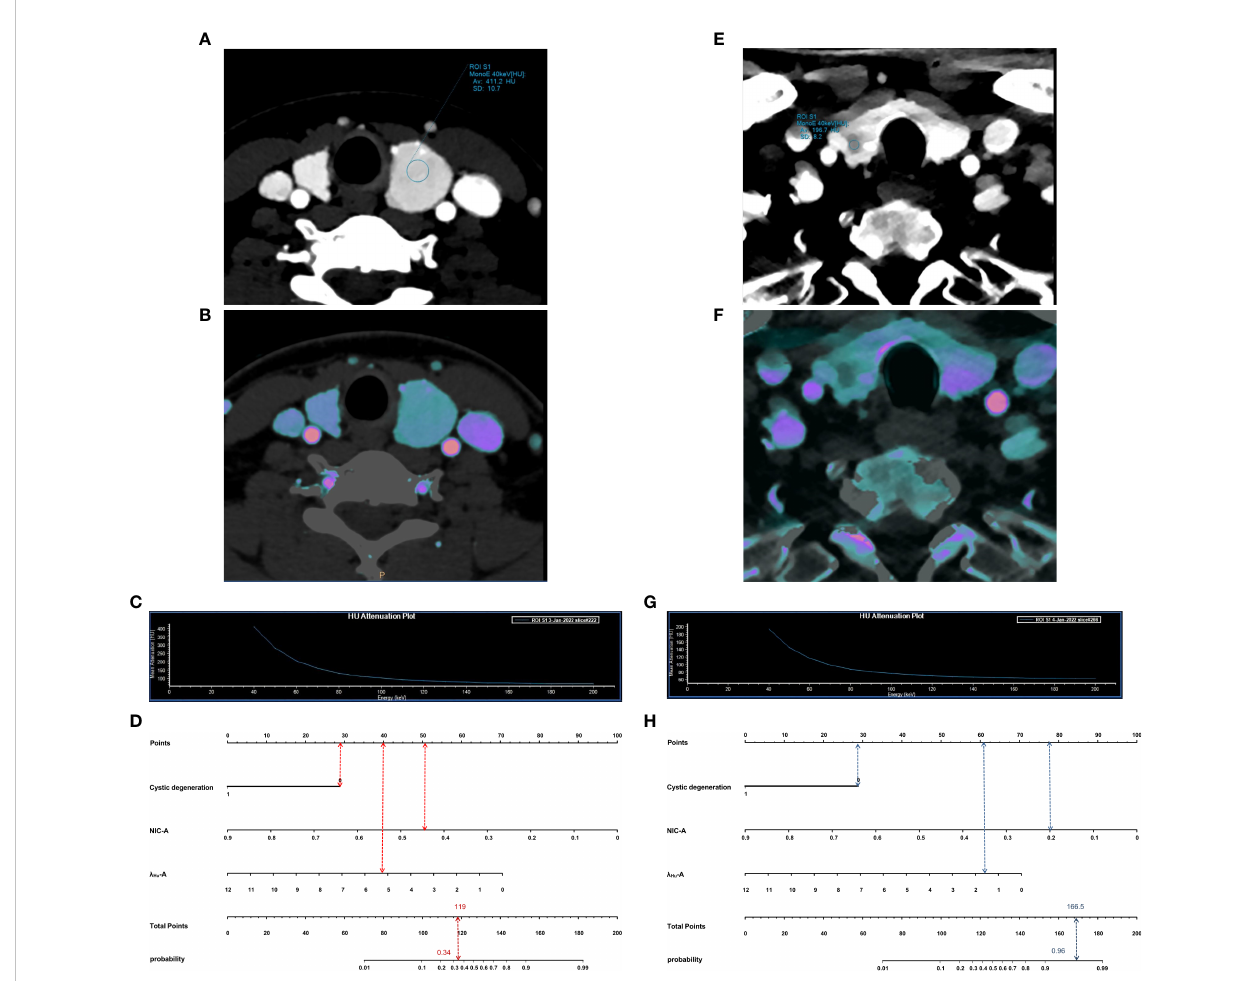
FIGURE 6 Examples of application of nomogram to predict probability of benign and malignant thyroid nodules. Each nomogram shows value of each predictor on axis for variable and its corresponding score on points scale. When points for all variables were added, total scores and corresponding risk probability were superimposed on scales showing total points and probability (risk). (A – D) , 54-year-old man with a benign thyroid nodule. Arterial phase 40-keV monochromatic image (A) , Iodine density image (B) and the slope of the spectral HU curve (C) show lesions. When points for individual predictors were added, total points were 119. Nomogram (D) shows that the probability of malignancy of this lesion was 0.34. E – H, 36- year-old woman with a malignancy thyroid nodule. Arterial phase 40-keV monochromatic image (E) , Iodine density image (F) and the slope of the spectral HU curve (G) show lesions. When points for individual predictors were added, total points were 166.5. Nomogram (H) shows that the probability of malignancy of this lesion was